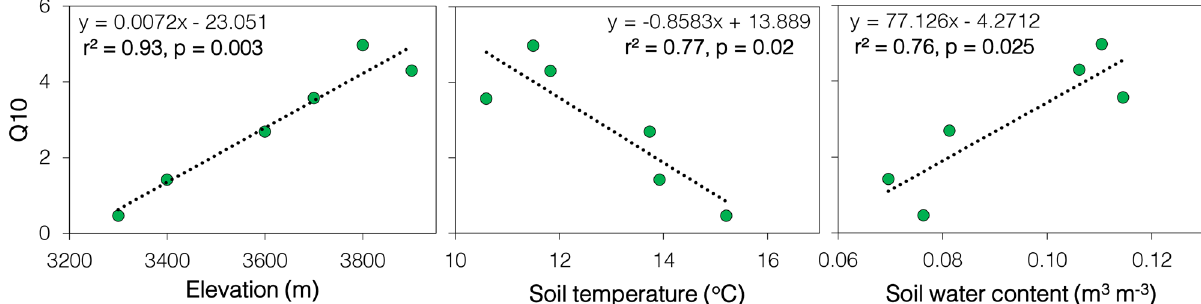
Figure 3. Effect of elevation, soil temperature, and moisture on the temperature sensitivity of SR. Linear models to show the significant and robust relationship (r 2 < 0.76, p < 0.05) between Q 10 (temperature sensitivity) of SR and elevation, soil temperature, and volumetric soil water